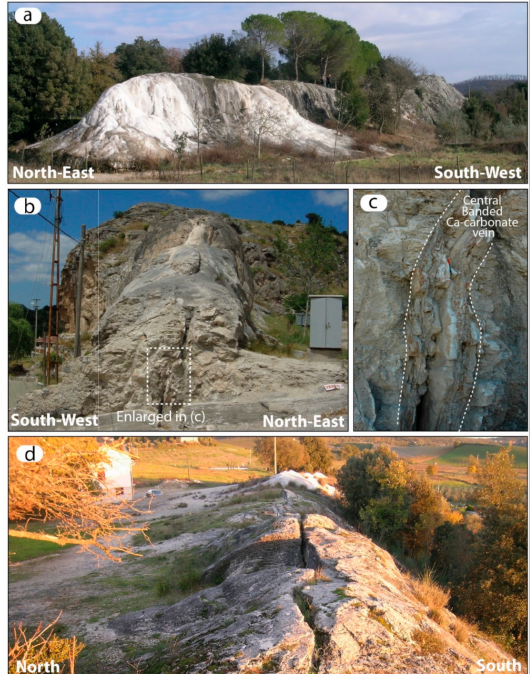
Figure 2. ( a ) General view of the Terme San Giovanni fissure ridge (Rapolano Terme, Italy); ( b ) Profile of a fissure ridge (Turkey) showing the central fissure partially filled by the banded Ca-carbonate vein; ( c ) Detail of the inset in b; ( d ) Fissure crossing the apical part of the ridge (Terme San Giovanni fissure ridge, Rapolano Terme,